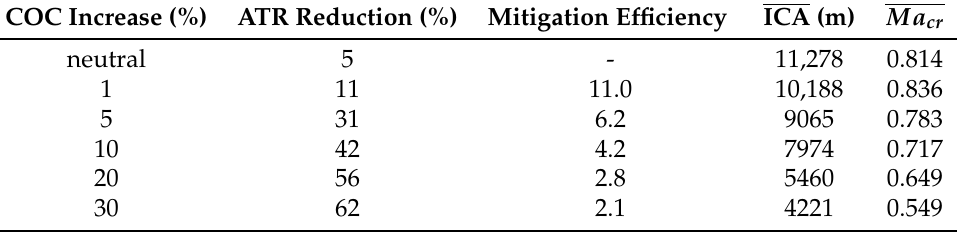
Table 4. Mitigation potentials and efficiencies relative to the reference cruise conditions. Related average ICA and Ma cr combinations are derived from the frequency distribution resulting at a given COC